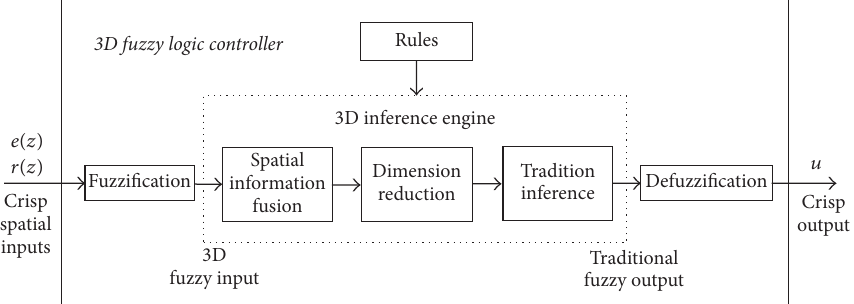
Figure 12: Basic structure of 3D FLC.